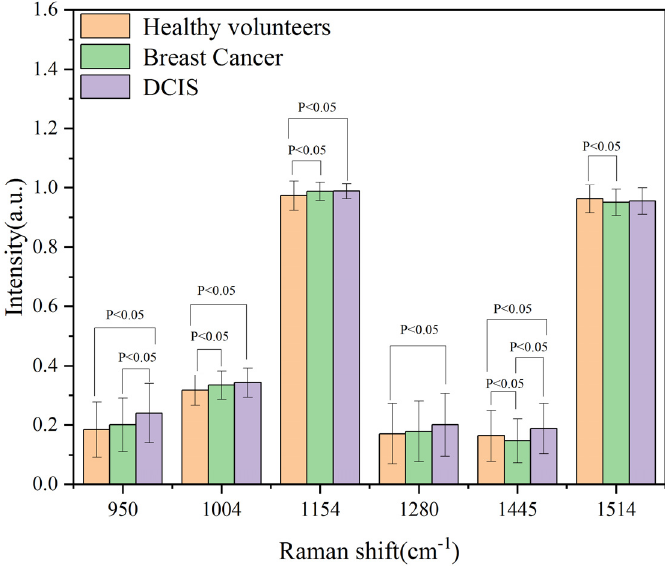
Figure 3. Comparison of normalized mean Raman spectra of serum sample for three groups: (1) Healthy volunteers (n = 241), (2) Breast cancer patients (n = 463) and (3) DCIS patients (n = 100). The shaded area is the standard deviation of the spectra.